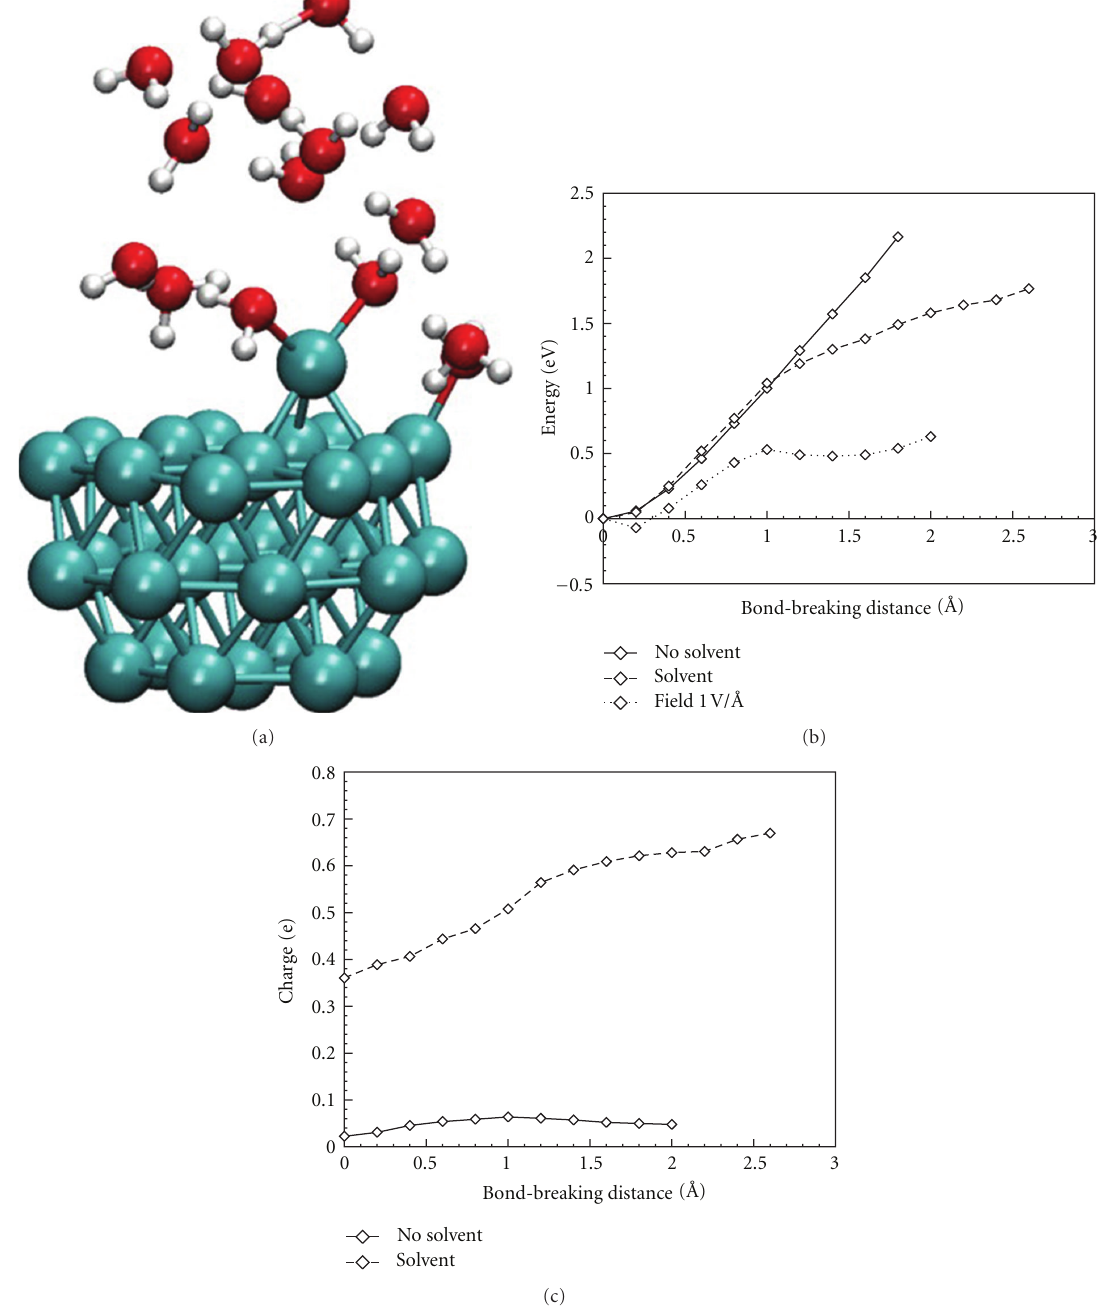
Figure 6: (a) Initial solvent-metal particle configuration, (b) electronic structure energies for dissolution/bond-breaking of a copper atom in proximity to a (111) copper surface, and (c) charges determined by the method of Bader for the copper adatom being “dragged” away from the (111) copper surface. Reproduced with permission from